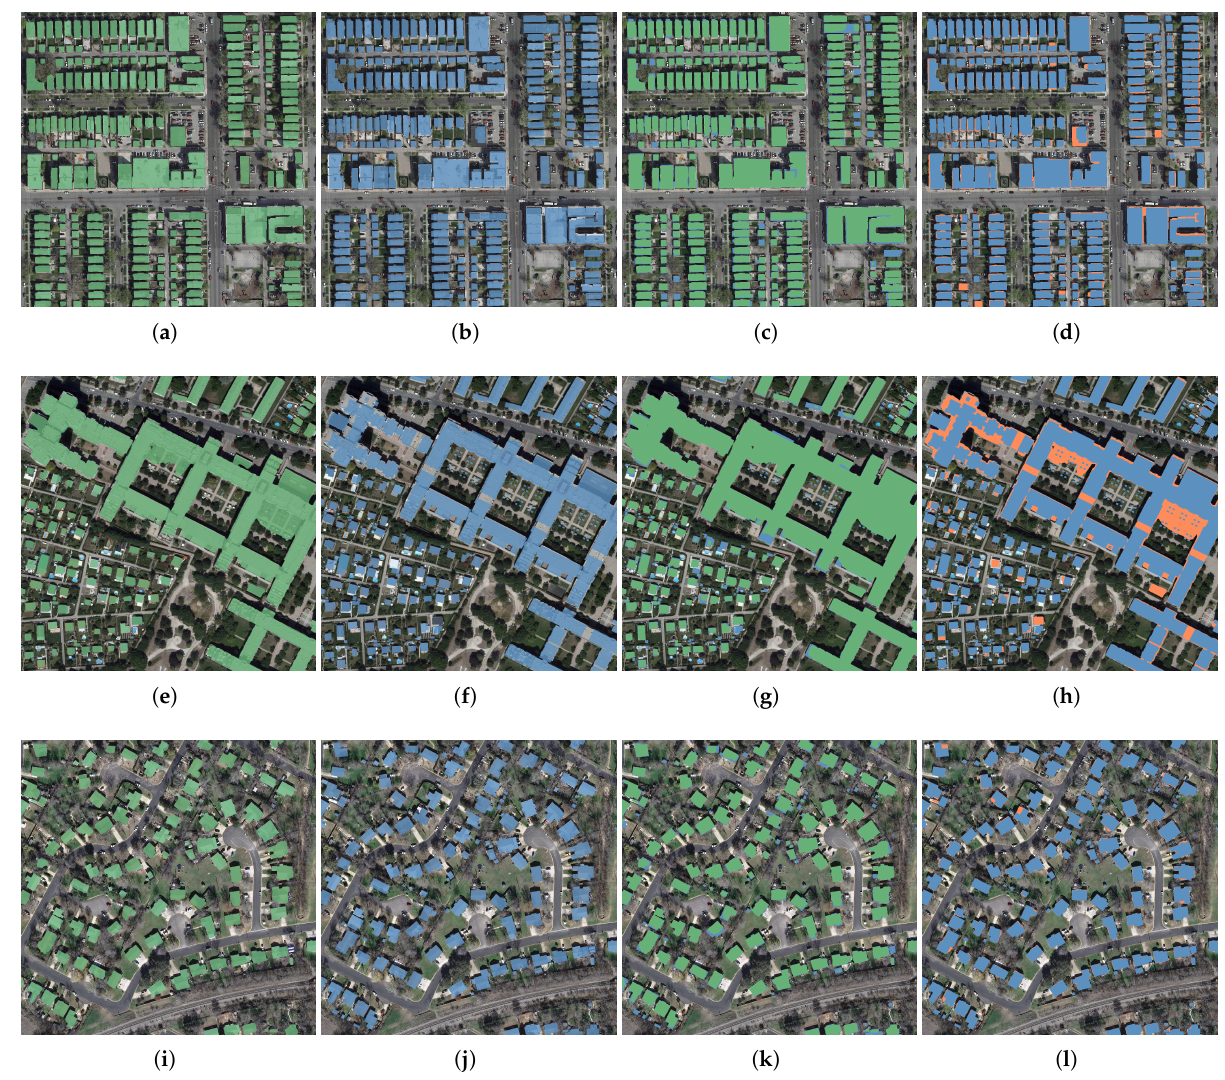
Figure 9. Visual results for the Inria dataset. The subfigures ( a , e , i ) in the left column are produced by the model with the geohash. The building pixels are labeled green. The subfigures ( b , f , j ) in the middle column are the ground truth in a blue color, the subfigures ( c , g , k ) are the combination of the prediction results and the corresponding ground truth, and the subfigures ( d , h , l ) highlight the false positive pixels with an orange color, which are misclassified as buildings. All the sample images have a size of 1024 ×